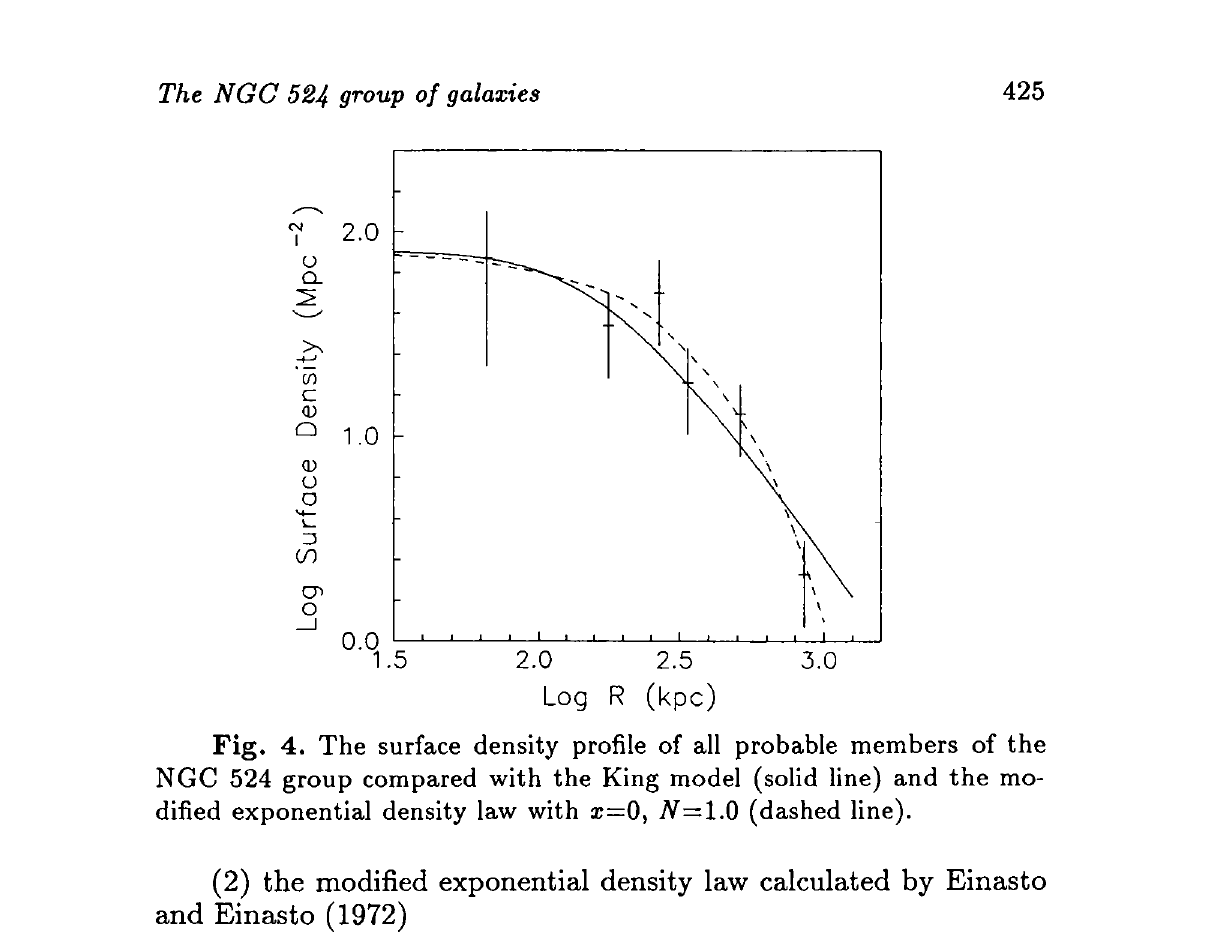
Fig. 4. The surface density profile of all probable members of the NGC 524 group compared with the King model (solid line) and the mo- dified exponential density law with z=0, JV = 1.0 (dashed